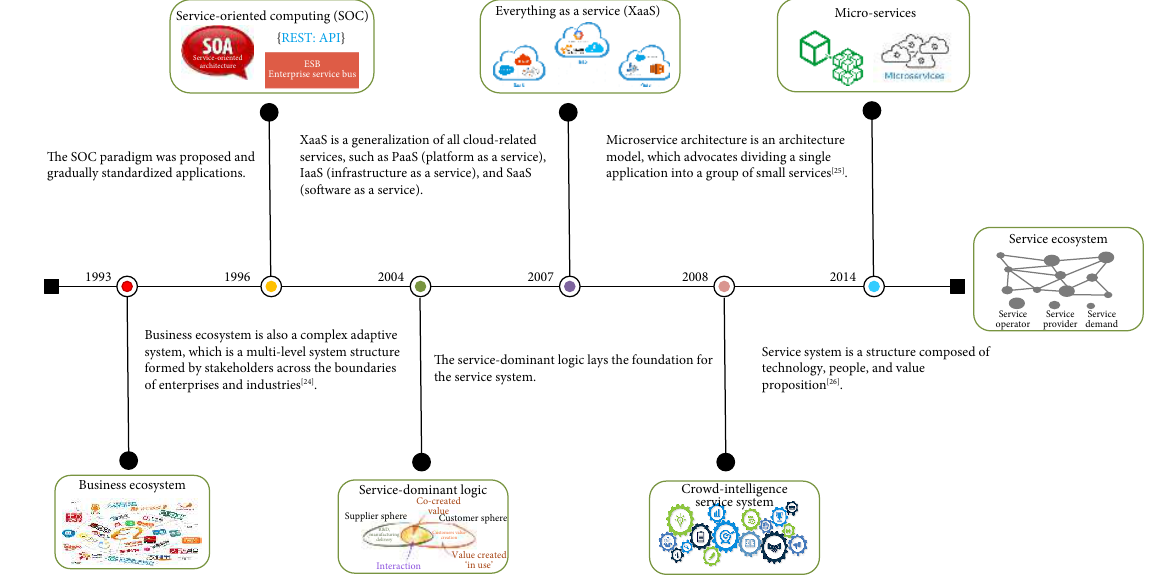
Fig. 1 Conceptual origin of a service